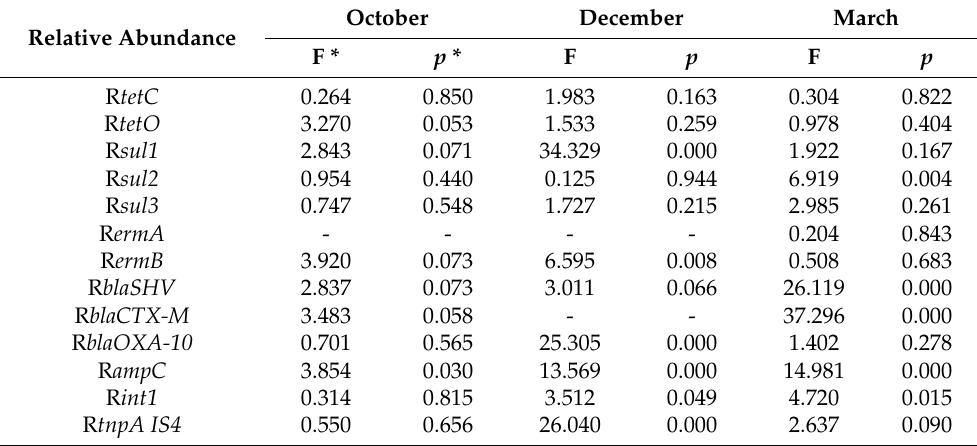
Table 1. ANOVA analysis of ARGs at different sampling points at different